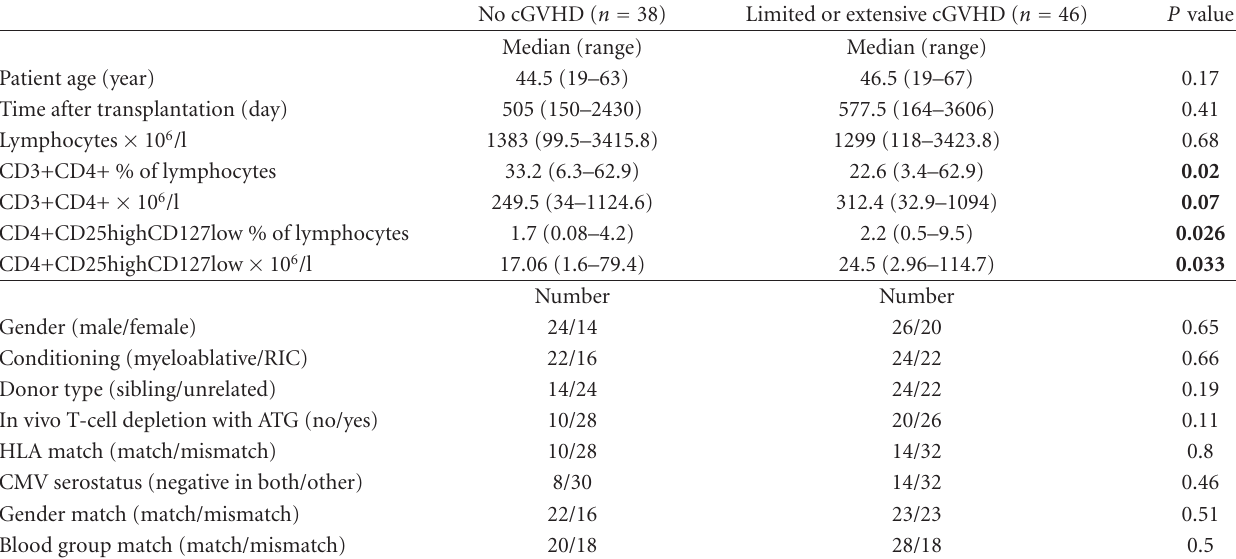
Table 3: Univariate analysis for chronic graft versus host disease (cGVHD).